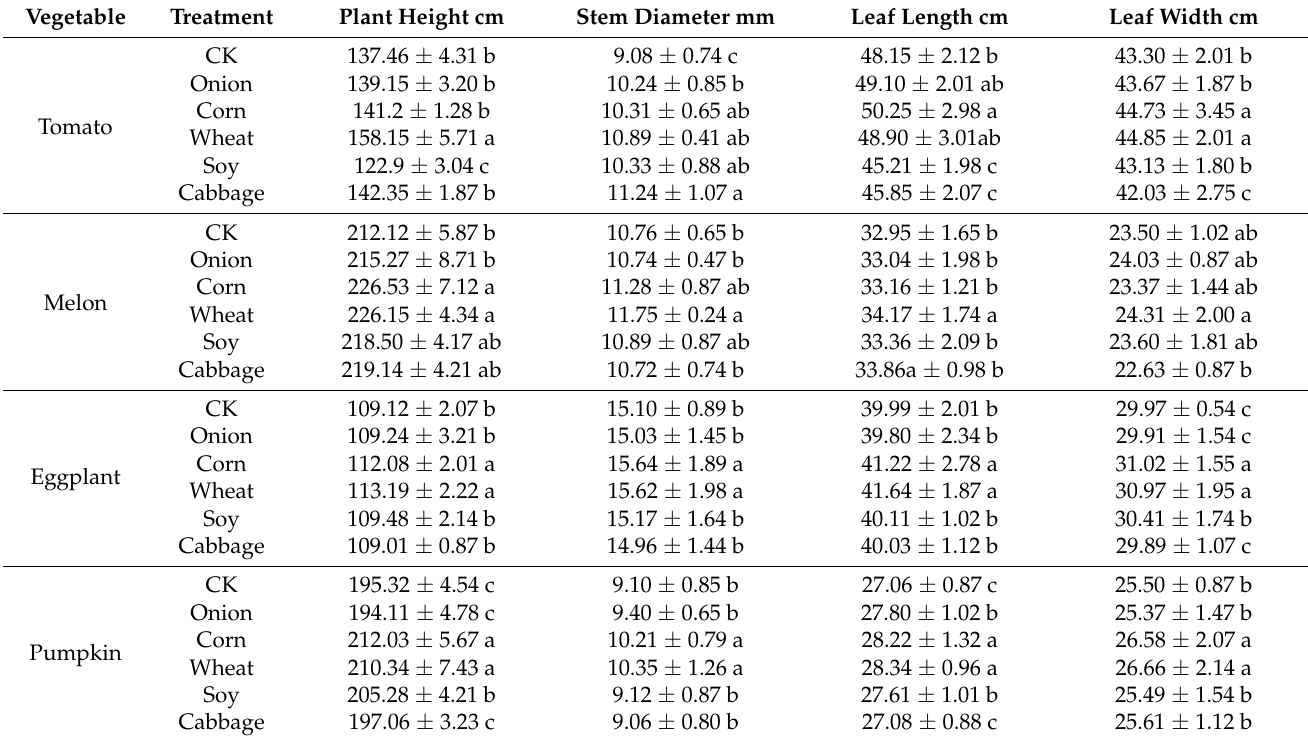
Table 2. Effect s of different catch crops on the growth of vegetables. Table 2. Effects of different catch crops on the growth of vegetables.